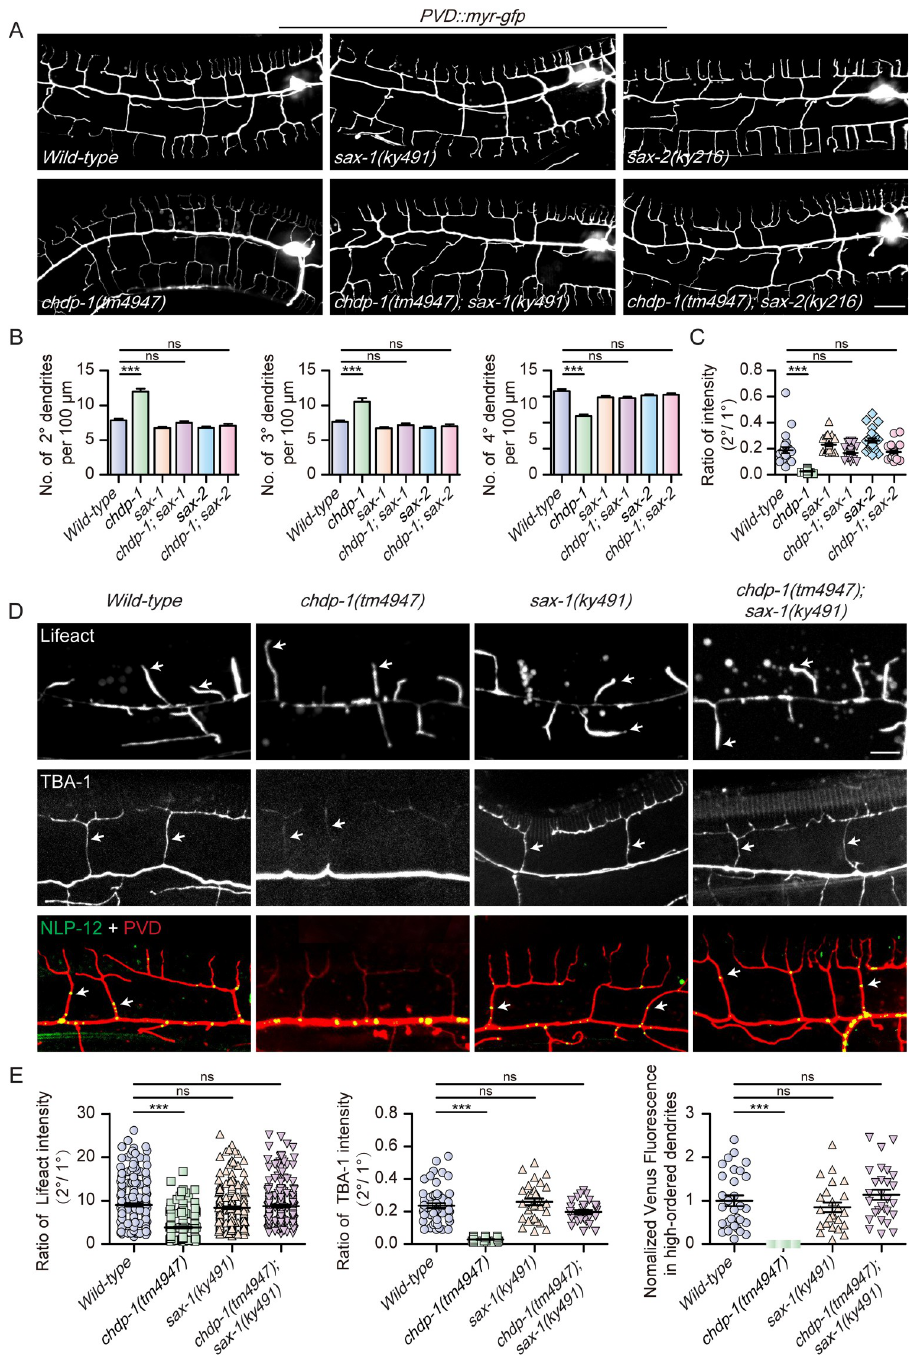
Fig 7. Knockout of sax-1 suppresses dendrite development defects in chdp-1 mutants. (A) Confocal images of PVD dendrites in wild-type , chdp-1(tm4947) , sax-1(ky491) , chdp-1(tm4947); sax-1(ky491) , sax-2(ky216) and chdp-1 (tm4947); sax-2(ky216) . Scale bar: 20 μ m. (B-C) Quantification of (B) the number of 2 o , 3 o and 4 o branches, and (C) the ratio of the 2 o branches to that of the intensity of the primary dendrites in the 100 μ m area anterior to PVD cell body for the genotypes indicated. Error bars, SEM. ��� p < 0.001 by one-way ANOVA with the Tukey correction. ns: non-significant. n = 20–30 for each genotype. (D) Confocal images of (top) Lifeact in early L3 stage (arrows: growth cones of 2 o branches with F-actin), (middle) TBA-1 (arrows: 2 o branches labeled by GFP::TBA-1), and (bottom) NLP- 12::Venus and myr-mCherry (arrows: dense-core vesicles in high-ordered branches) in wild-type , chdp-1(tm4947) , sax- 1(ky491) and chdp-1(tm4947); sax-1(ky491) . Scale bar: 10 μ m. (E) Quantification of (left) the ratio of the